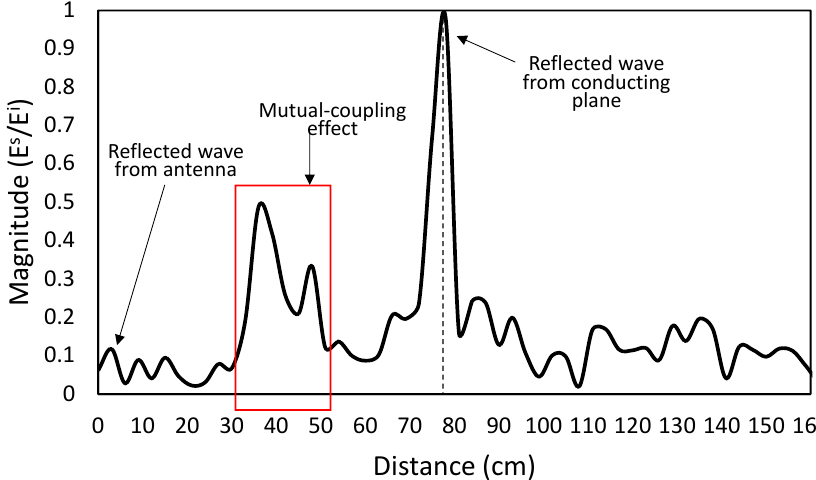
Figure 8. Time-domain response of the scattered wave from the conducting plane.